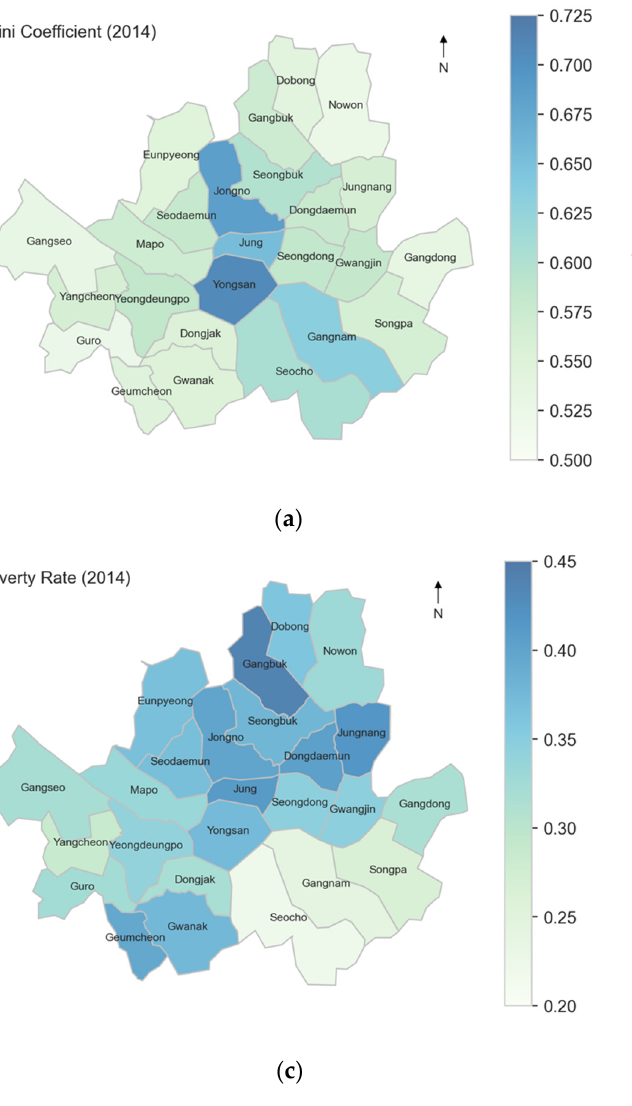
Figure 2. Gini coefficients and poverty rates in 2014 and 2018 across 25 districts in Seoul: ( a ) Gini coefficient of equivalized income in 2014; ( b ) Gini coefficient of equivalized income in 2018; ( c ) poverty rate in 2014; ( d ) poverty rate in 2018.